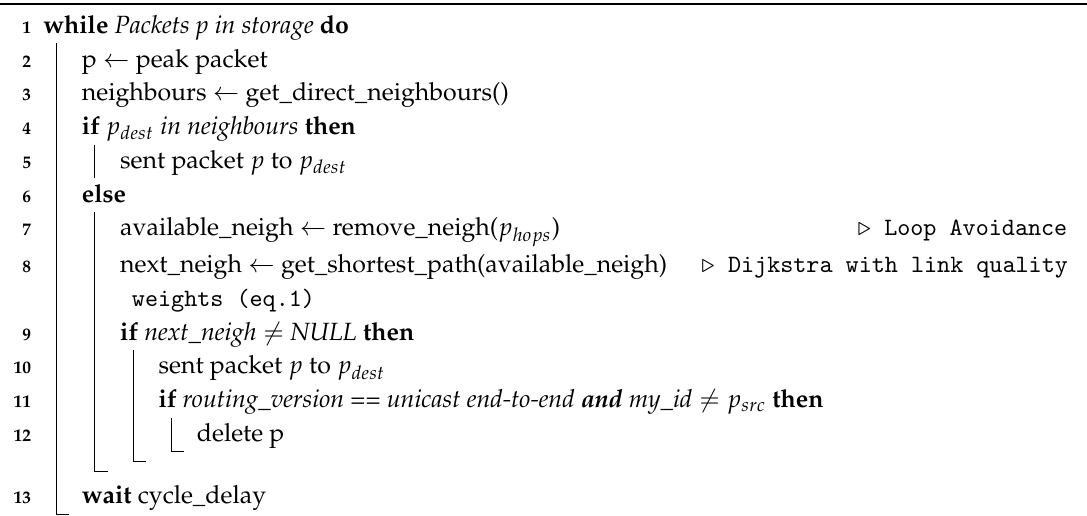
Algorithm 1: Routing decision algorithm (decision logic).